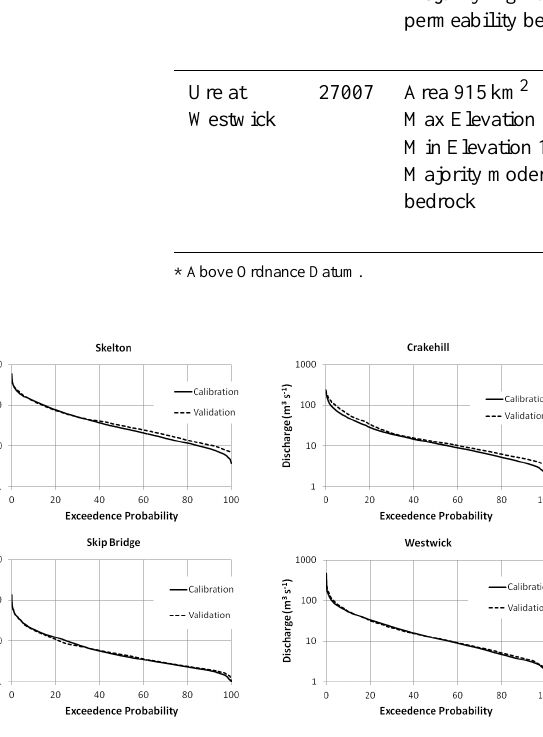
Figure 7. Exceedence probability plots for the four gauging stations.